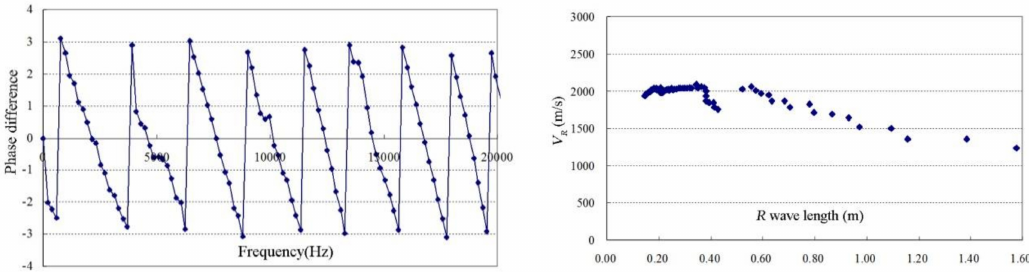
Figure 11. Phase spectrum and dispersion curve of the layered model 3 @ receiver spacing 60 cm.